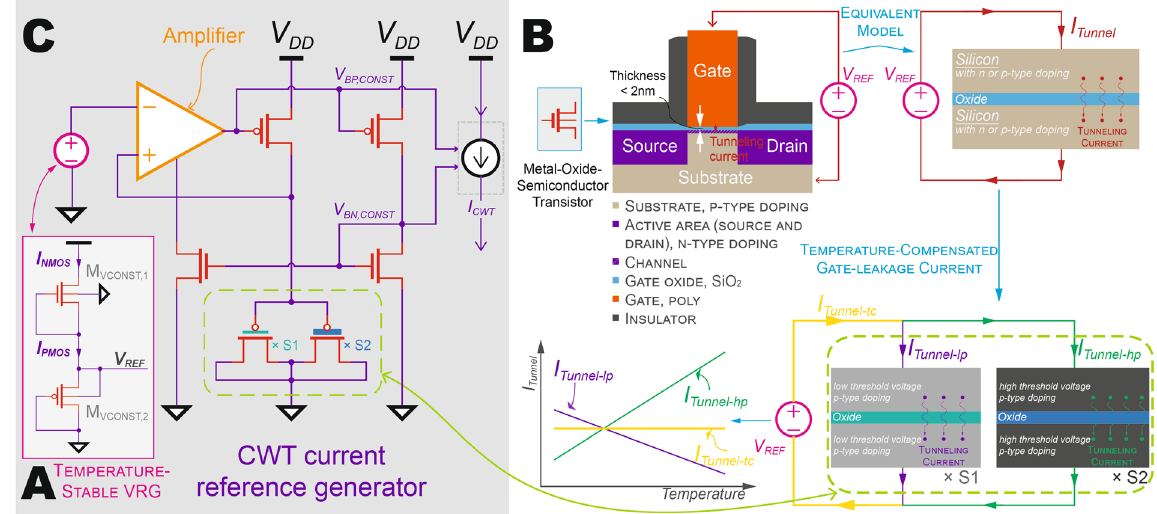
Figure 1. Subthreshold operation and gate-leakage in temperature-stabilized voltage and current reference generators in 65 nm CMOS technology. ( A ) Temperature-stabilized 2 T pW VRG operating in saturated subthreshold region. ( B ) Tunneling current in thin-gate CMOS transistors and temperature-compensated gate- leakage current. ( C ) Monolithic implementation of the pA-level CWT current reference